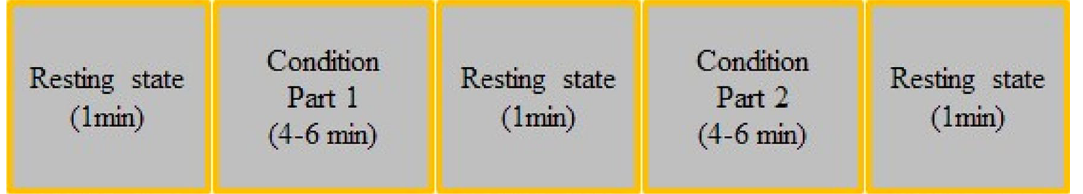
Figure 1. The structure of an experimental condition. All experimental conditions consisted of two parts with three resting-state phases before, in between, and after the condition.